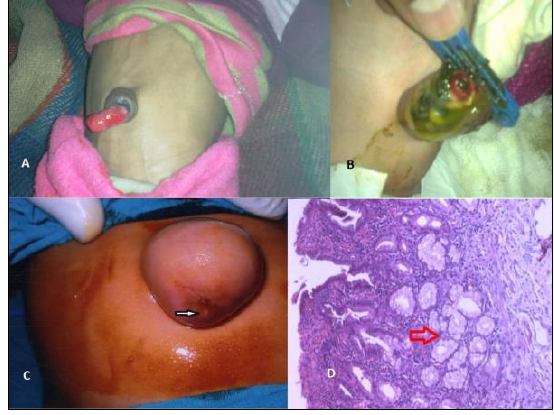
Figure 1: A- Prolapsed patent VID. B- Meconium discharge from patent VID. C- Umbilical hernia harboring MD. Arrow shows site of attachment of MD to the underside of skin. D- Histopathology showing ectopic gastric mucosa (Arrow). Both the patients who could not be operated ex- pired whereas there was no postoperative